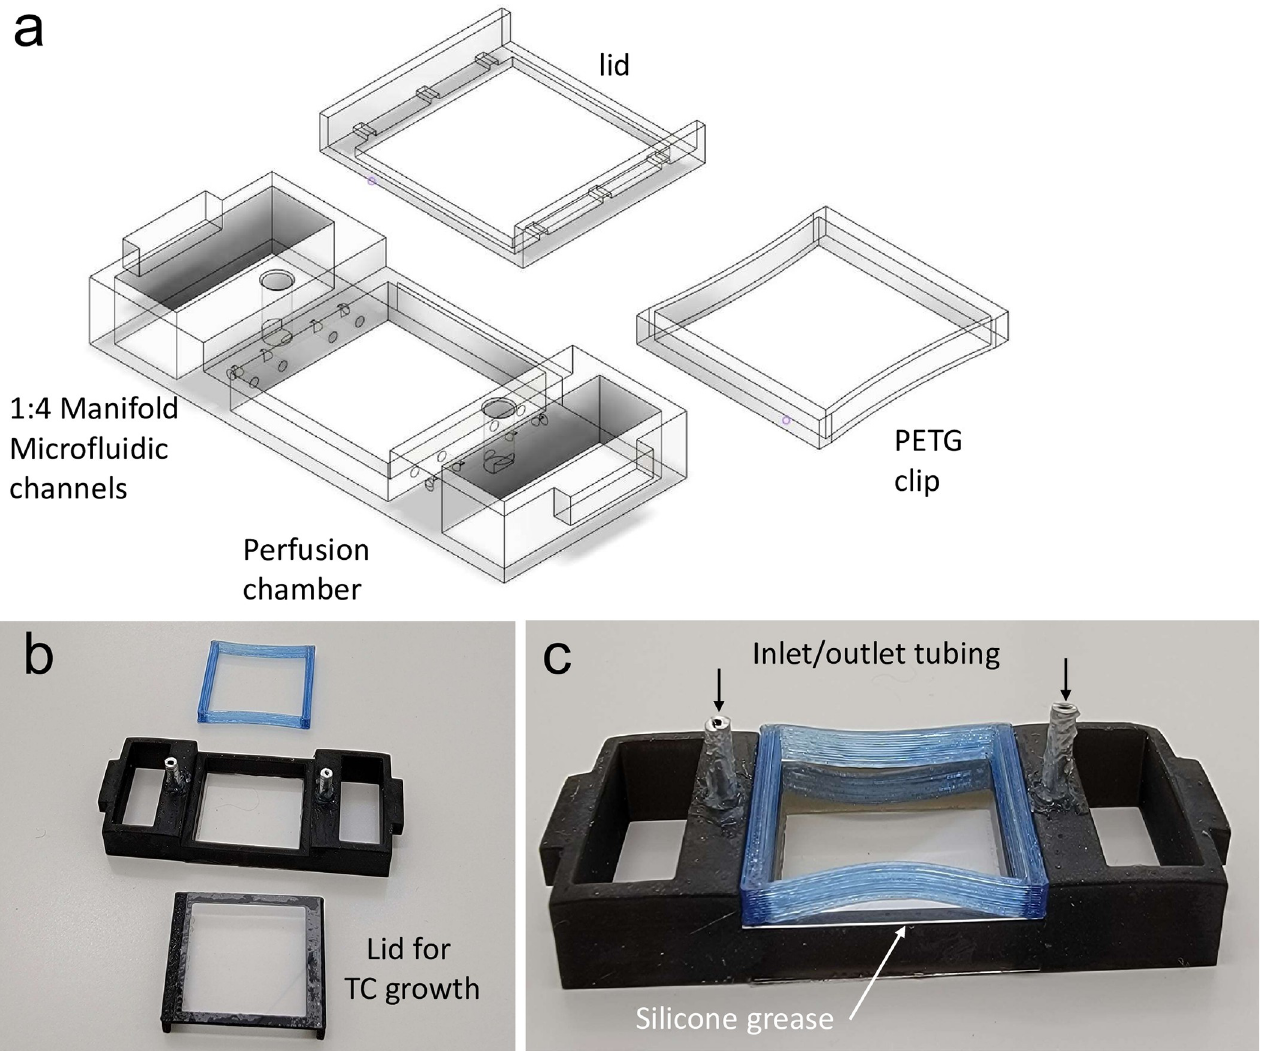
Fig 6. Chamber UV sterilization. (a) 3D printed curing/sterilization chamber lined with aluminum foil tape with a 30W 385 nm LED flood lamp placed on top. (b) Alternate method of chamber sterilization in a UV curing chamber with rotating platform (Electrolite ELC-500). In both methods the chambers are placed in clear polypropylene